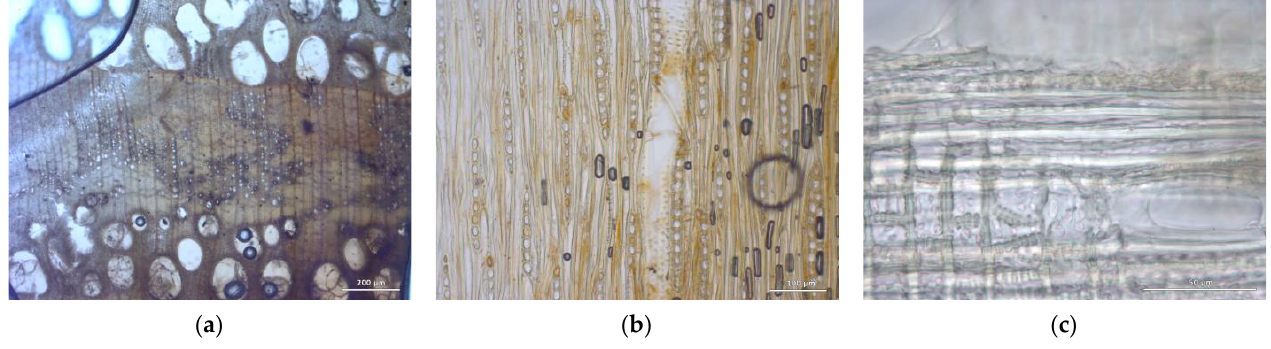
Figure 6. Characteristic sections identified as belonging to the species Castanea sativa Miller: ( a ) Cross-section of sample L3b; ( b ) Tangential section of sample LU1a; ( c ) Radial section of sample AS2.